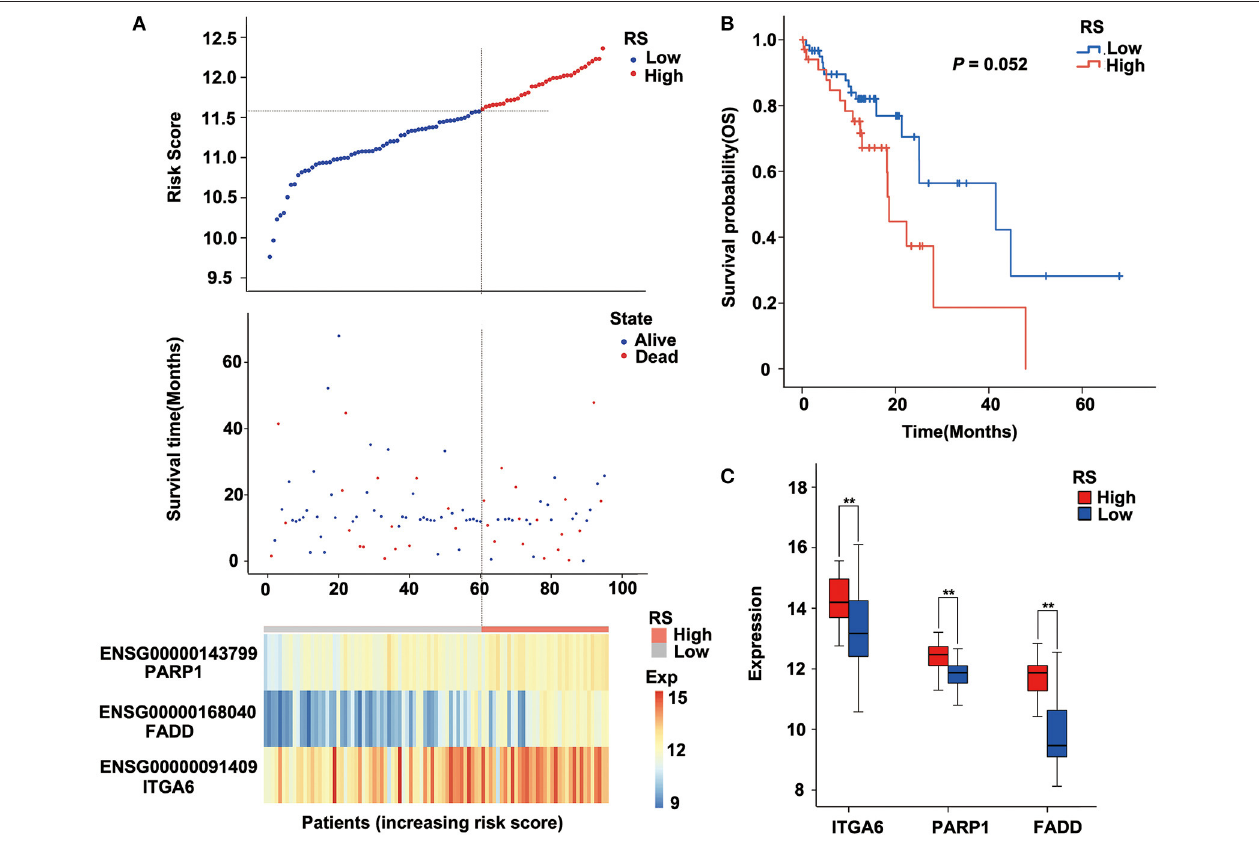
FIGURE 5 | Performance of the three-gene signature model in the validation cohort [The Cancer Genome Atlas (TCGA) data]. (A) Risk score, survival time, survival state, and expression of the three ARGs in esophageal squamous cell carcinoma (ESCC) patients of TCGA. (B) Kaplan–Meier analysis of ESCC patients grouped by risk score; log-rank Mantel–Cox test was used to compare survival curves. (C) Box plot of expression of three ARGs grouped by risk score, and the independent-sample Student t -test was used as the comparison method between the high- and low-risk groups. RS, risk score; Exp, expression. ** P <